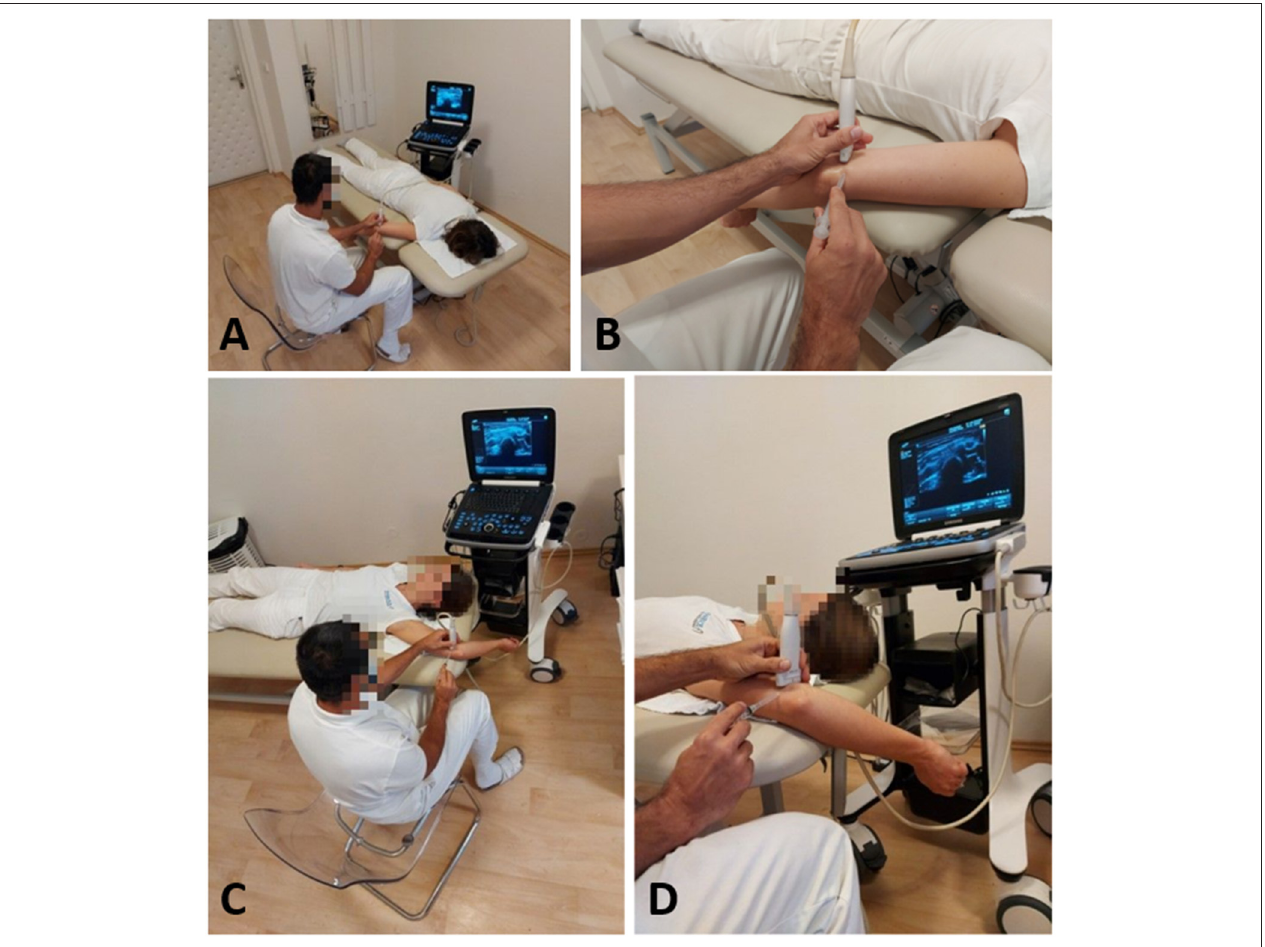
FIGURE 10 | (A) Prone position for the ultrasound-guided ulnar nerve in-plane injection with the elbow flexed and hanging over the examination bed. (B) The same procedure as described before in detail. (C) Supine position for the ultrasound-guided ulnar nerve in-plane injection; the patient is positioned on the examination bed with the elbow flexed and hand over the head. (D) The same procedure as described before in